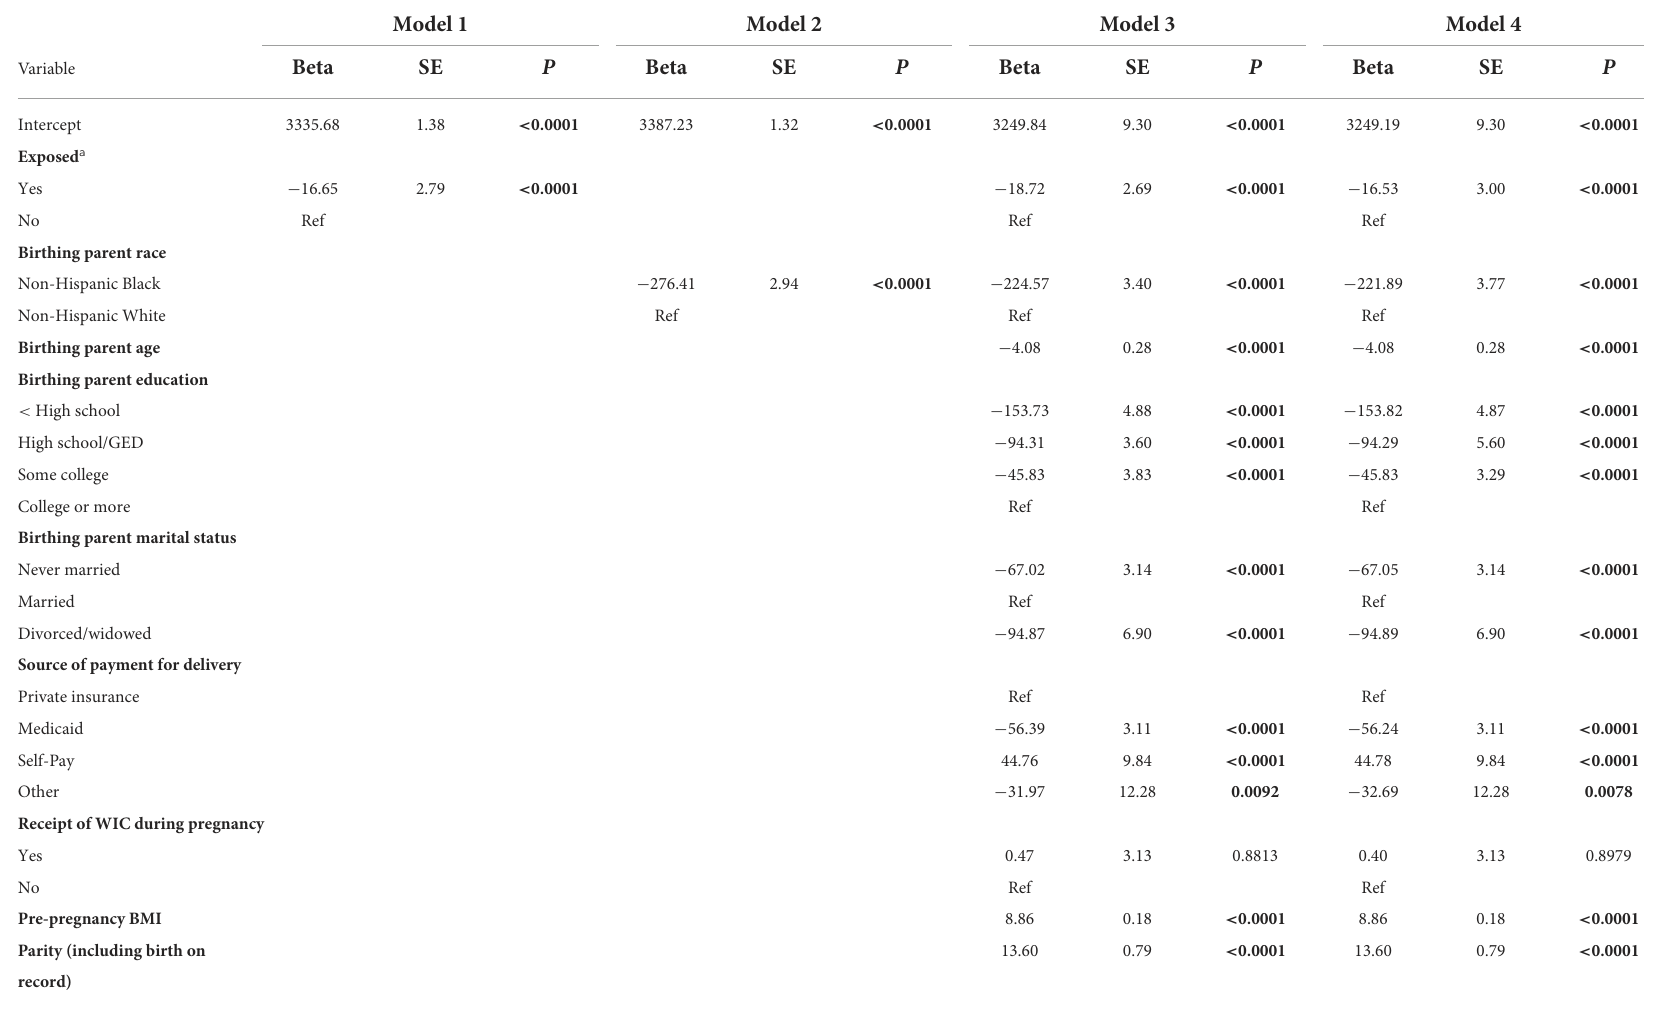
TABLE 2 Linear regression coefficients for regression of birthweight (grams) on exposure to the Flint Water Crisis emergency declaration in Michigan ( n =